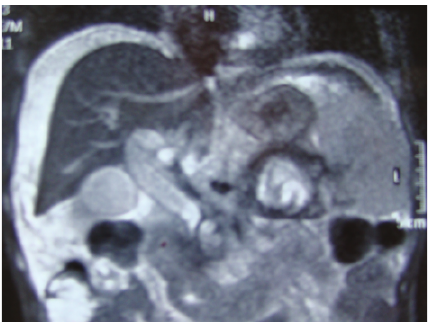
Figure 1: Preoperative magnetic resonance image showing retropancreatic collection, partial necrosis of the pancreatic body, normal liver appearance, and